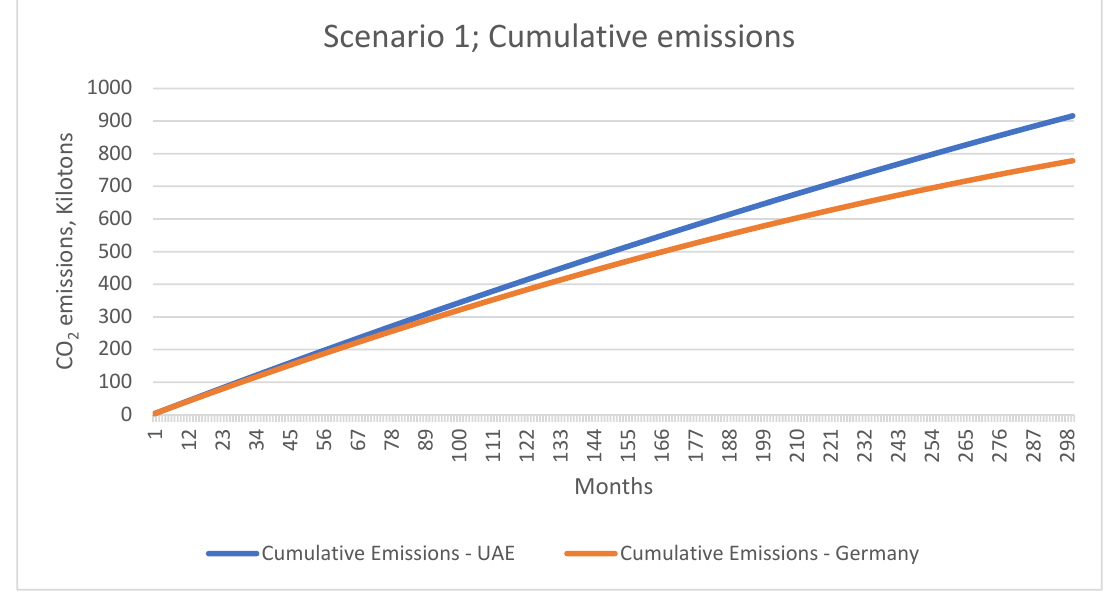
Figure 7. Cumulative emissions through electricity consumption for UAE and DE under scenario 1.